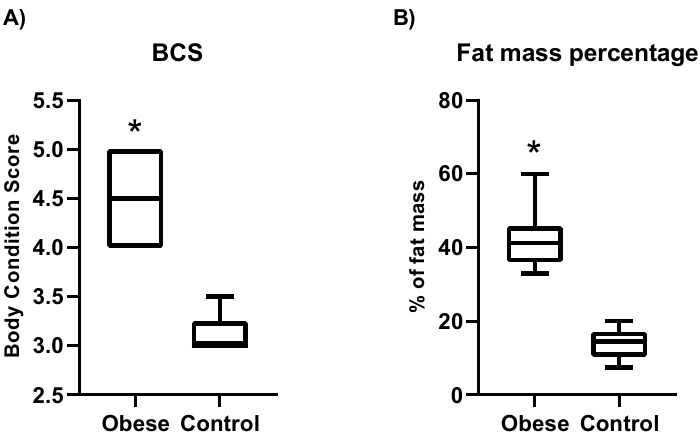
Figure 1. Changes in body condition score (BCS) ( A ) and body fat mass percentage among obese and control dogs ( B ). The plot shows the median (line within box), 25th and 75th percentiles (box), and the range (whiskers). Asterisks indicate significant differences between the obese group and the control. * p < 0.05; BCS: body condition score.